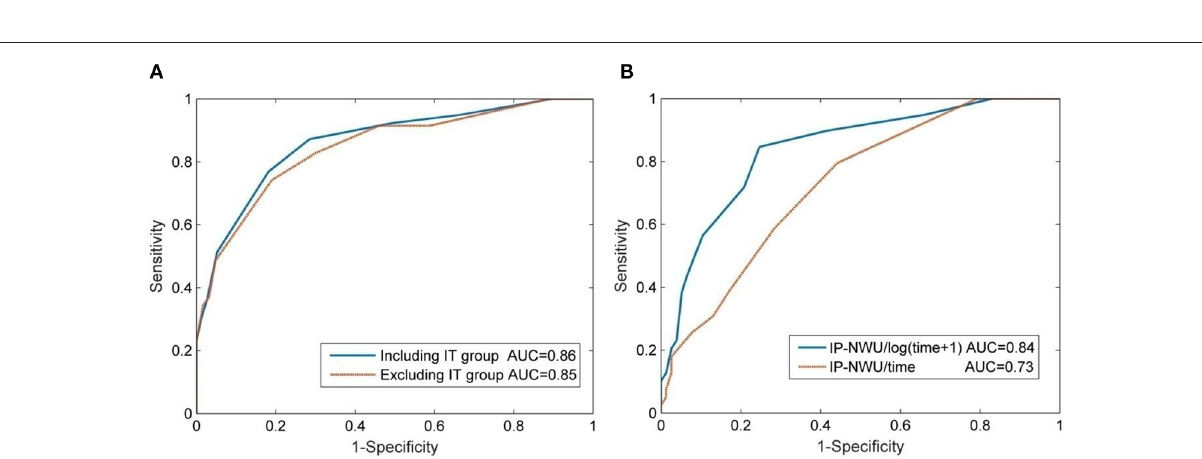
Frontiers in Neurology |